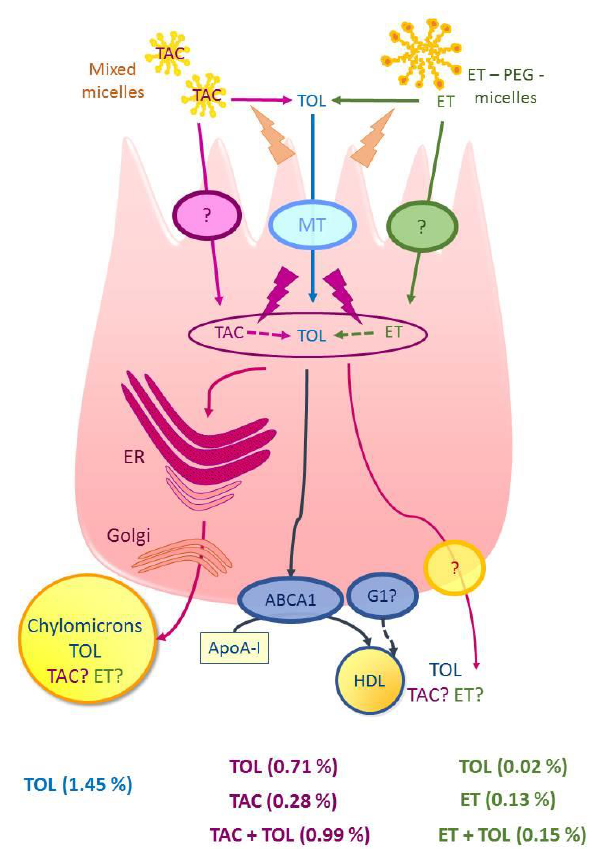
Figure 4. General view of the absorption/secretion of the different forms of tocopherol by the enterocyte. Consumption of α -tocopherol (TOL) leads to its uptake by the intestine and secretion in the circulation in chylomicron and HDL particles together with triacylglycerol and cholesterol. TAC and esterified tocopherol (ET) in the form of PEGylated α -tocopherol (ET-PEG, i.e.,TPGS) may be hydrolyzed to free α -tocopherol in the stomach by non-enzymatic hydrolysis, in the proximity of the brush border epithelium by esterase hydrolysis, and at the surface of the enterocytes via a lipase. Alternatively, entire TAC or ET can pass through cell membranes, thereby enabling the absorption of the intact TAC or ET molecule. A certain proportion of TAC and ET can then be se- creted in their entire form. The percentages indicate the fraction secreted at h24 compared to the amount in the apical compartment at h0. TAC + TOL (or ET + TOL) indicates the tocopherol equivalent from the apical amount of TAC (or ET-PEG). Abbreviations: ABCA1: ATP-binding cassette A1; ApoA-1: apolipoproteine A1; ER: endoplasmic reticulum, ET: esterified tocopherol; G1: ATP-binding cassette G1; HDL high density cholesterol; MT: membrane transporter; PEG: poly- ethylene-glycol; TAC: tocopherol acetate; TOL: α-tocopherol; TPGS: α-tocopheryl polyethylene glycol succinate 1000.